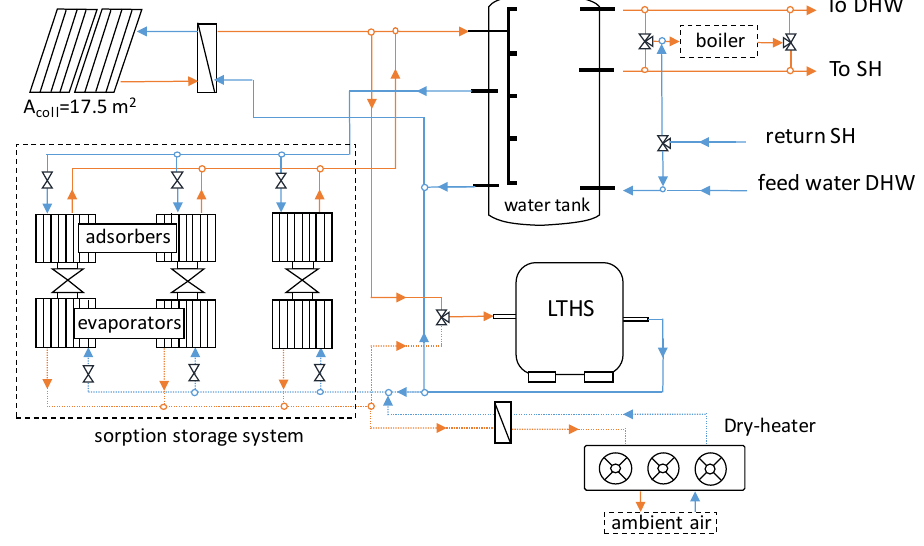
Figure 3. Schematic of the system for winter configuration.